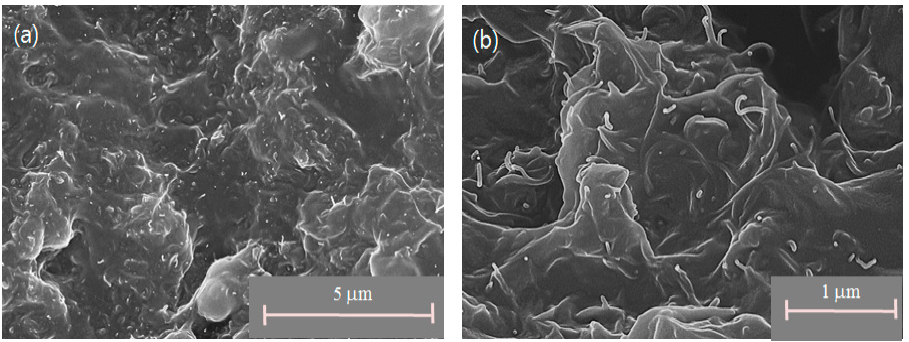
Figure 3. SEM images of the CNT/PDMS composite, with magnification: ( a ) 10,000 × and ( b ) 30,000 × .